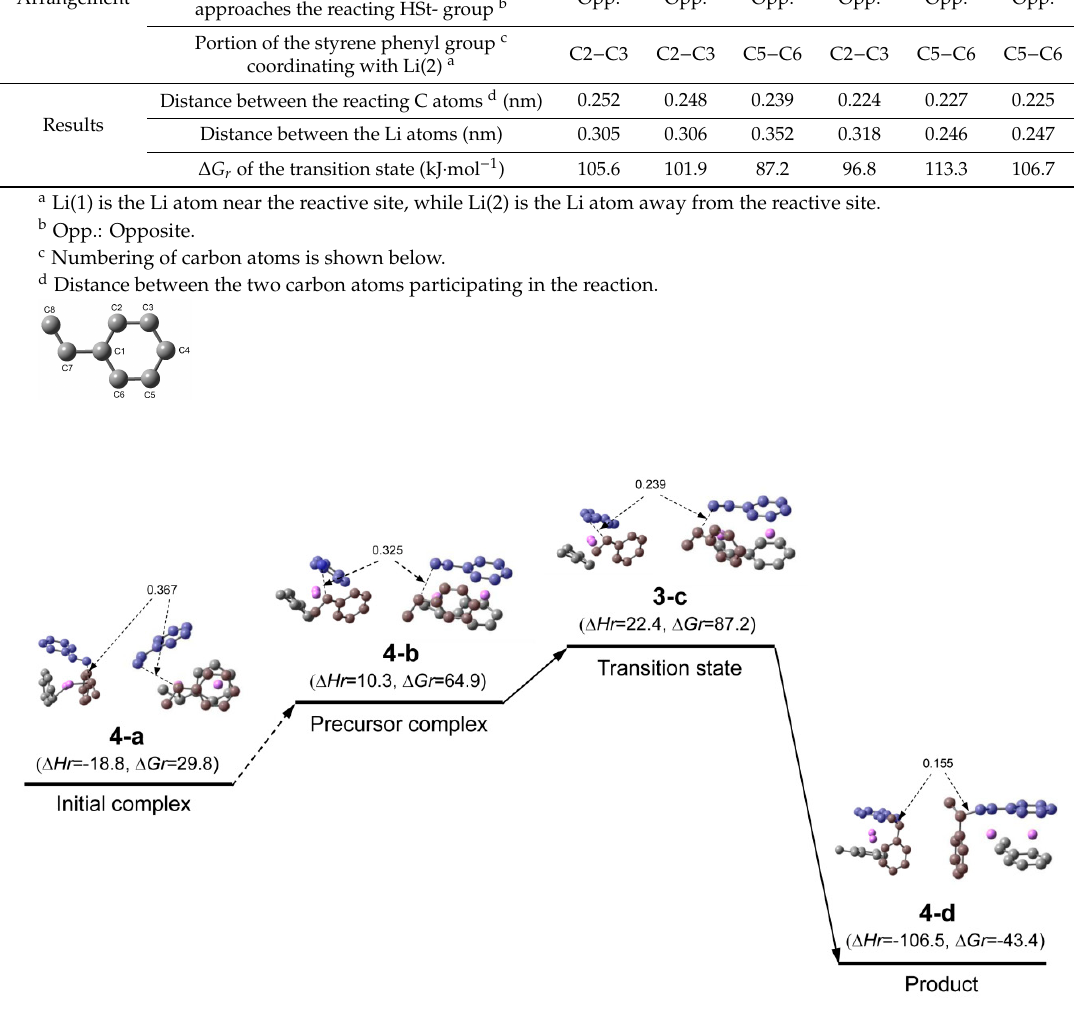
Figure 4. Reaction pathway for St/[(HStLi) 2 ( 1-c )] (system(dim-r)) in the gas phase. Although the reaction proceeds in three steps, only the first complex of the first step ( 4-a ) (the initial complex) and three structures of the final step ( 4-b , 3-c and 4-d ) are shown here (the complete pathway is shown in Figure A1 of Appendix A2). The small drawing on the left side of each structure is the side view of the right-hand side drawing. Carbon atoms of styrene are colored in blue, while those of the reacting HSt- group are colored in brown. In each drawing the two carbon atoms participating in the reaction are connected by dotted or full line and the distance between them is shown in nm. Hydrogen atoms are not shown. ∆ H r and ∆ G r , the relative enthalpy and free energy, respectively, are expressed in kJ·mol − 1 .